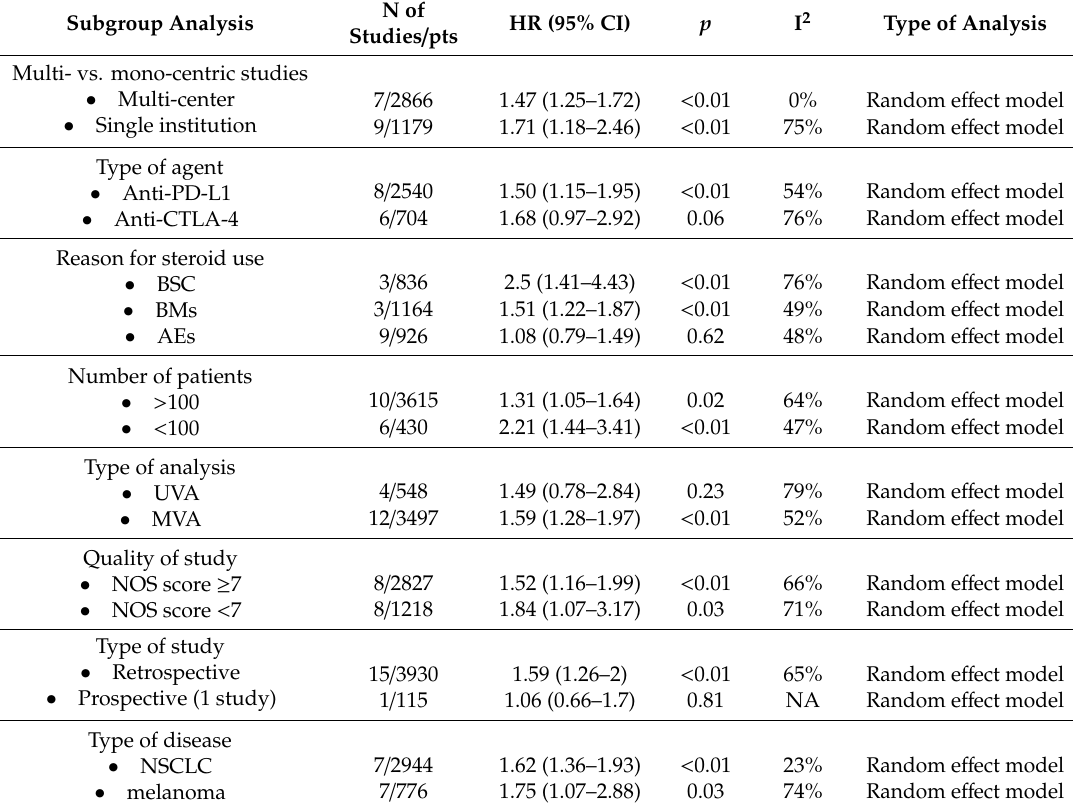
Table 2. Subgroup analysis for overall survival.